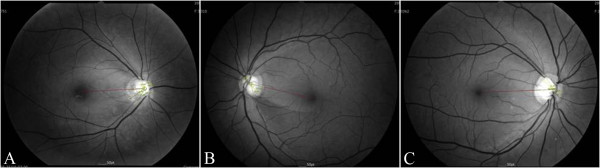
Typical retinal nerve fiber layer (RNFL) defects in eyes with high myopia (A), low to moderate myopia (B), and emmetropia (C). (A) The right eye of a 46-year-old male patient with −6.75 diopters of spherical equivalent (angle I = 30.95°, angle II = 59.04°, MD:-3.03). (B) The left eye of a 37-year-old female patient with −2.00 diopters of spherical equivalent (angle I = 37.85°, angle II = 25.87°, MD:-1.09). (C) The right eye of a 50-year-old female patient with −0.25 diopters of spherical equivalent (angle I = 40.89°, angle II = 15.69 °, MD: -2.97).